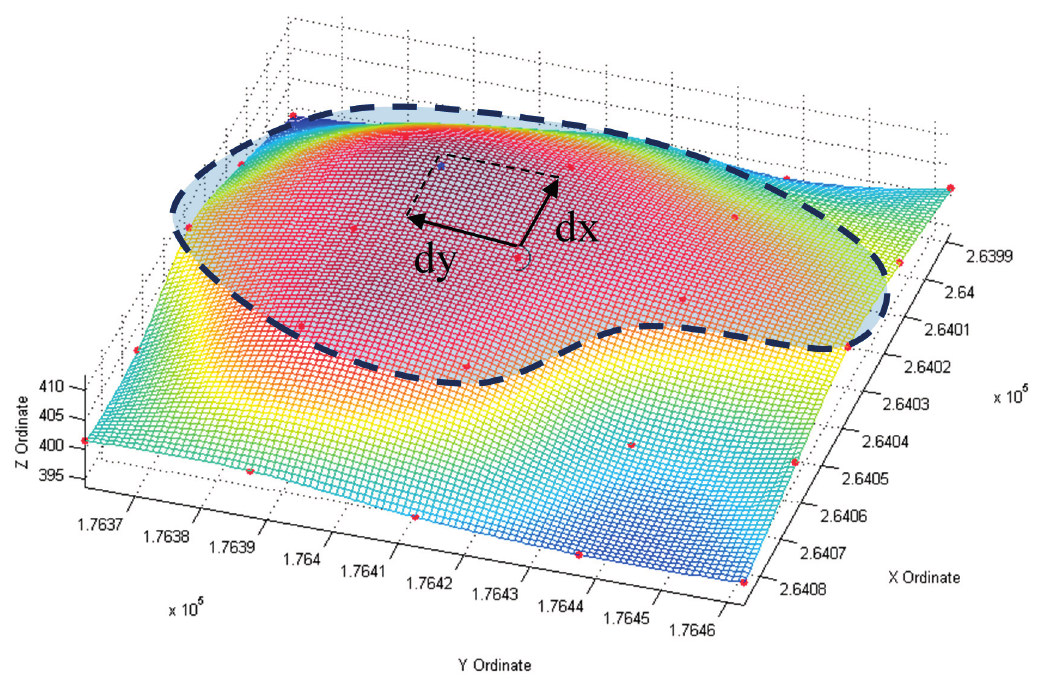
Figure 5. Clustering (dashed polygon) and local interpolation (depicted with dx and dy ) around cluster-maxima for the identification of the precise position of interest point (blue